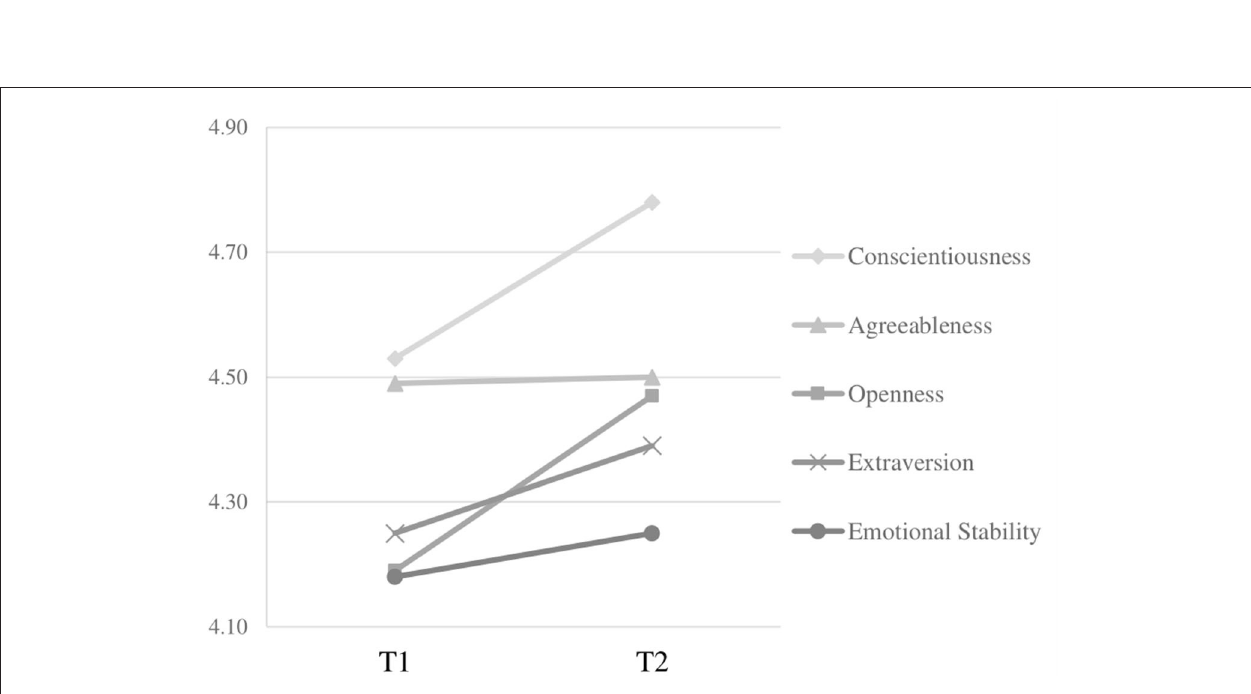
FIGURE 2 | Mean-level changes in Big Five dimensions over measurement occasions T1 and